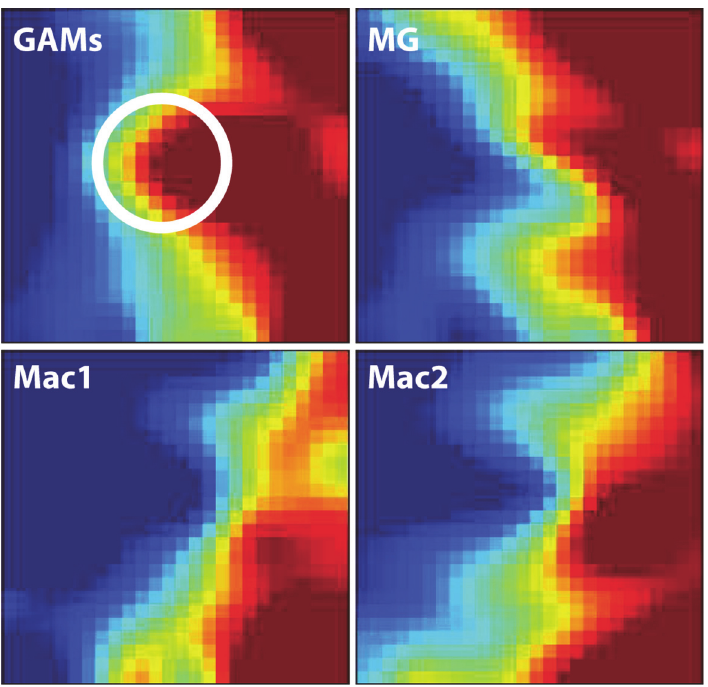
Fig 1. Graphical representation of gene expression patterns in the four data sets. The four GEDI maps show that the gene expression patterns of GAMs and naive microglia are more similar to each other than both macrophage datasets (blue colour indicating low and red colour high mRNA expression levels). The white circle highlights a central cluster of highly expressed genes in GAMs that is different from naive microglia. GAMs: glioma-associated microglia/macrophage microarray data; MG: naive microglia microarray data; Mac1: external data set from Keller, Mazuch et al. 2009; Mac2: external data set from Young, Eksmond et al. 2012.